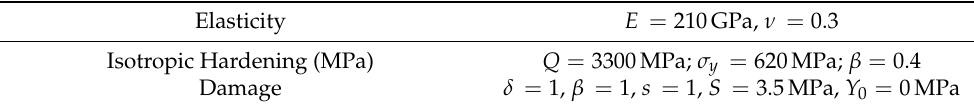
Table 2. Material properties of perforated square steel plate.